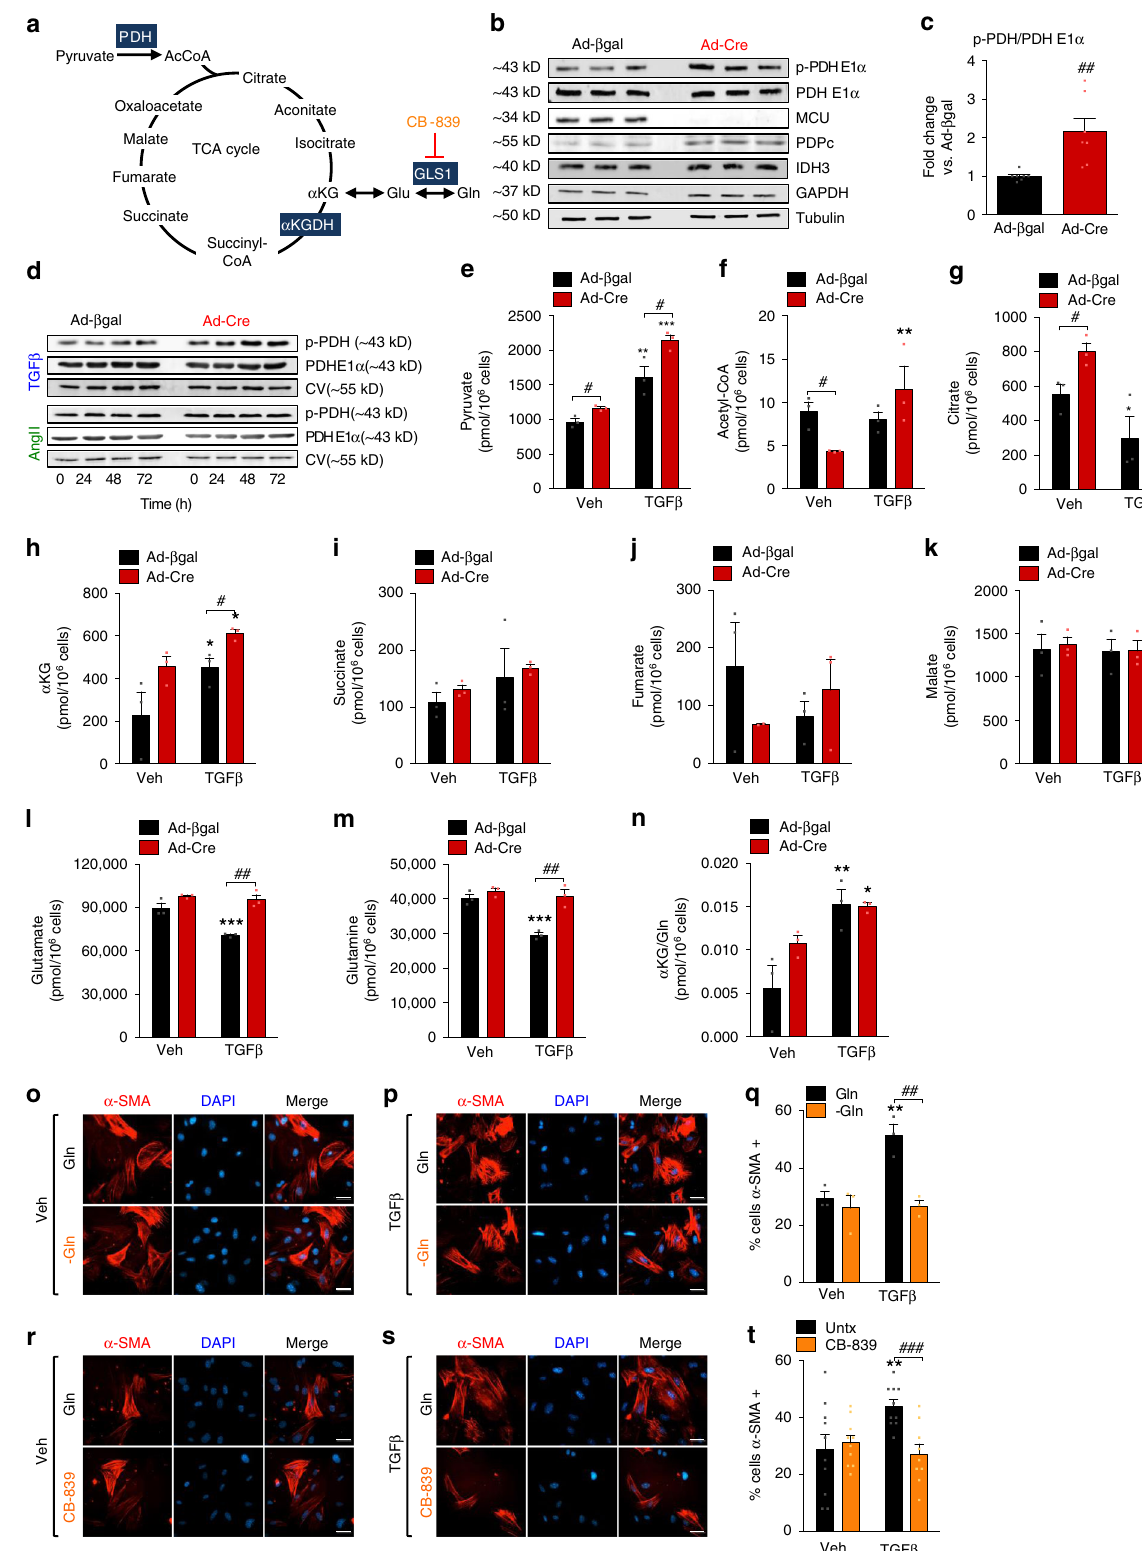
vs. Col1a2-CreERT controls (Fig. 6n). In addition, chronic AngII signi fi cantly increased myo fi broblast formation in Mcu fl / fl × Col1a2-CreERT hearts vs. Col1a2-CreERT as determined by α -SMA + /CD31 − immunohistochemistry staining (Fig.